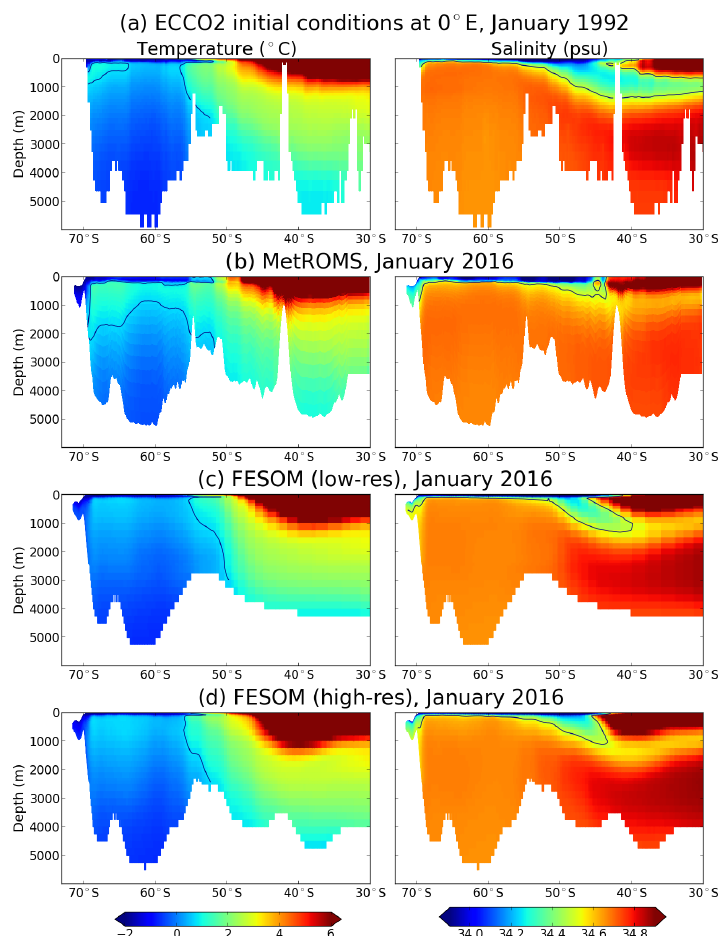
Figure 5. Temperature in ◦ C (left) and salinity in psu (right) interpolated to 0 ◦ E (Greenwich Meridian). Black contours show the 0 . 75 ◦ C isotherm and the 34.5psu isohaline. (a) Initial conditions for January 1992 from the ECCO2 reanalysis (Menemenlis et al., 2008; Wunsch et al., 2009). (b–d) January 2016 monthly average for MetROMS, low-resolution FESOM, and high-resolution FESOM,